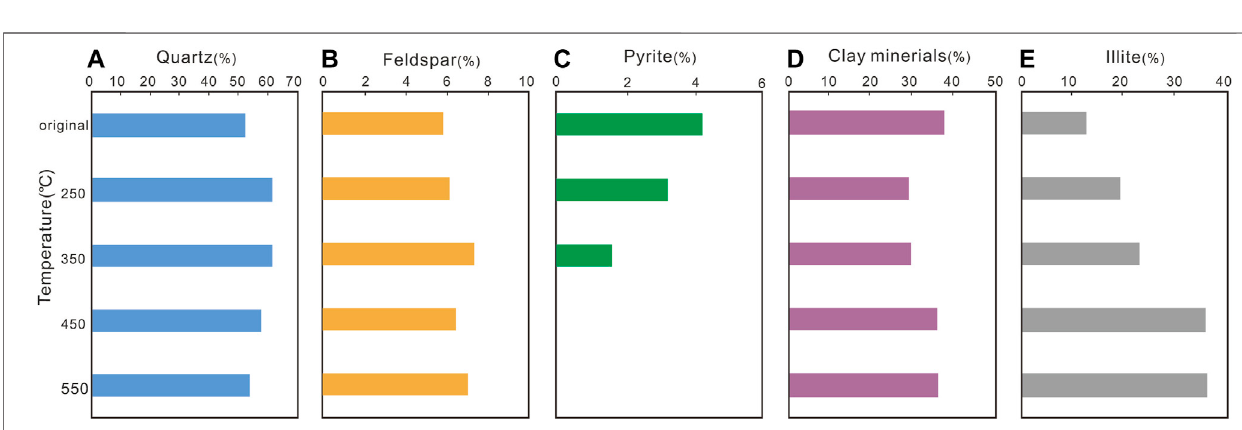
Frontiers in Earth Science |